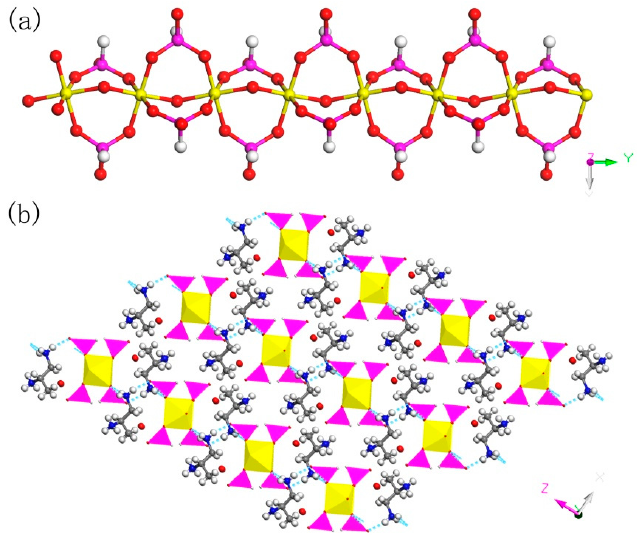
Figure 6. ( a ) 1D chain structure of 2 along the (010) direction. ( b ) The pseudo-2D structure of 2 with hydrogen bond connections . P, pink; Ga, yellow; N, blue; C, gray; H, white; O, red. H 5 In 2 P 3 O 10 , 3 . It contains three crystallographically distinct P atoms, two crystallographically unique In atoms, nine oxygen atoms, and one coordinate water molecule (Figure 4c). All of the P atoms are coordinated to three O atoms and a terminal H atom. The P-O bond varies from 1.505(3) Å to 1.558(3) Å and O-P-O bond angles are in the range of 103.7–114.90(18)°. The P-H bond lengths are 1.3205 Å , 1.2239 Å, and 1.3038 Å. Each of the In atoms is octahedrally coordinated to six oxygen atoms. The In-O distance varies from 2.072(3) Å to 2.237(3) Å, while the O-In-O bond angle changes from 84.64(11)° to 170.72(13)° (Table S1c). 3 is a 3D inorganic open-framework indium phosphite